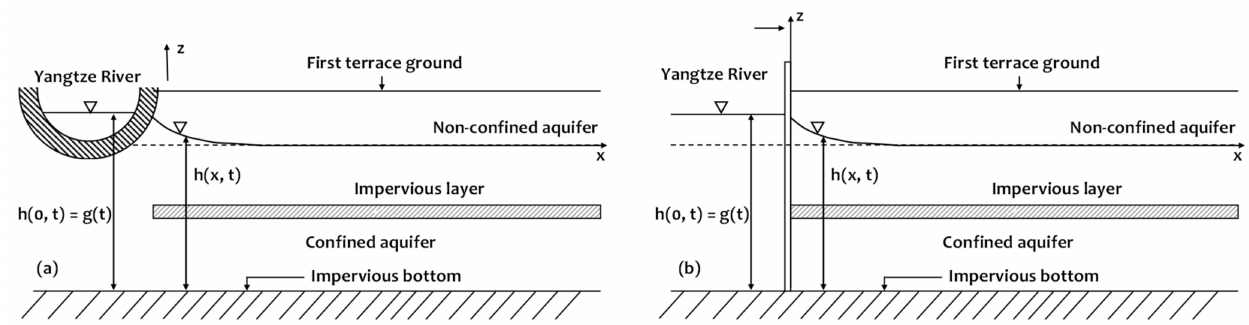
Figure 7. Generalized hydrogeological model of the riverine area on the Hankou first terrace: ( a ) actual situation; ( b ) idealized